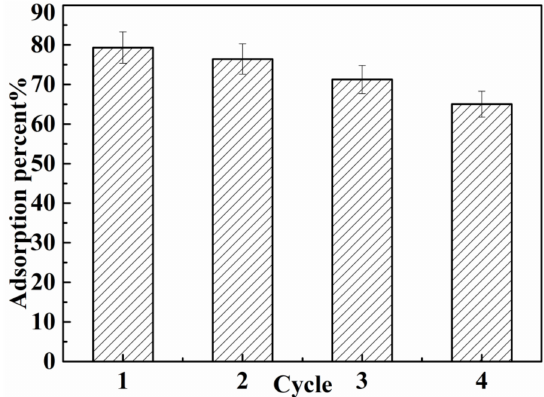
Figure 8. Reusability of BA-PGMA